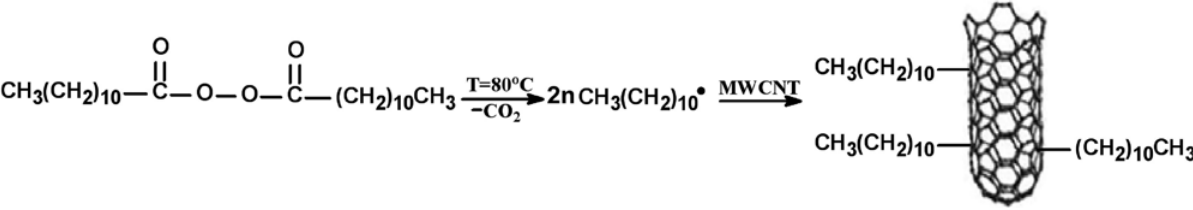
Figure 37. Steps for the preparation of undecyl-functionalized MWCNTs. Reproduced with permission from ref.